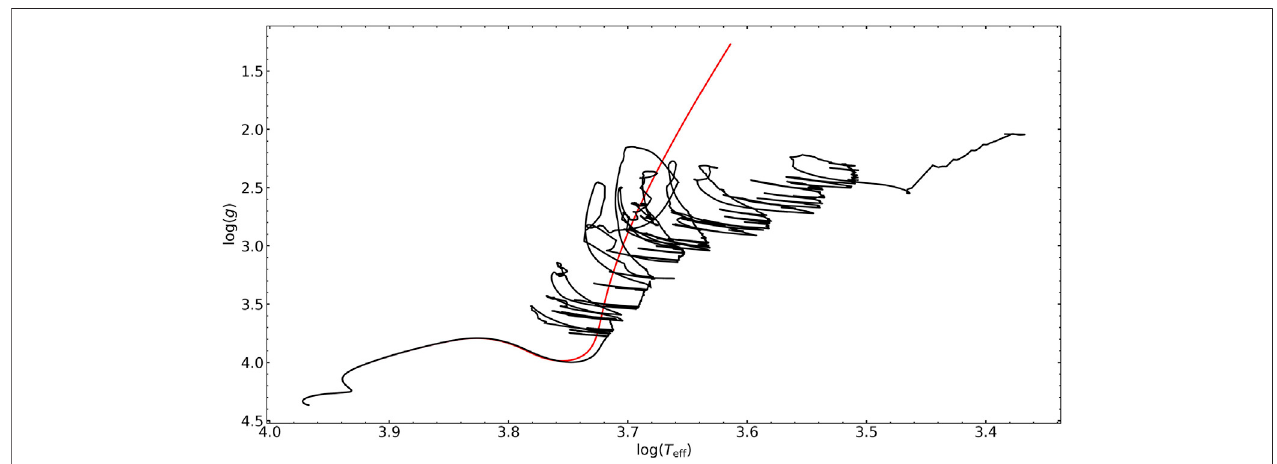
FIGURE 2 | Kiel diagram of the pre-main sequence models shown in Figure 1 . The classical mode (red) follows the well known Hayashi track before entering the Henyeytrack andcontractingontotheZAMS. Thediskmediatedmodel(black)showstheeffectoftime-dependentaccretionrates.Theevolutionfollows averychaotic route before entering the Henyey track and converging with the classical